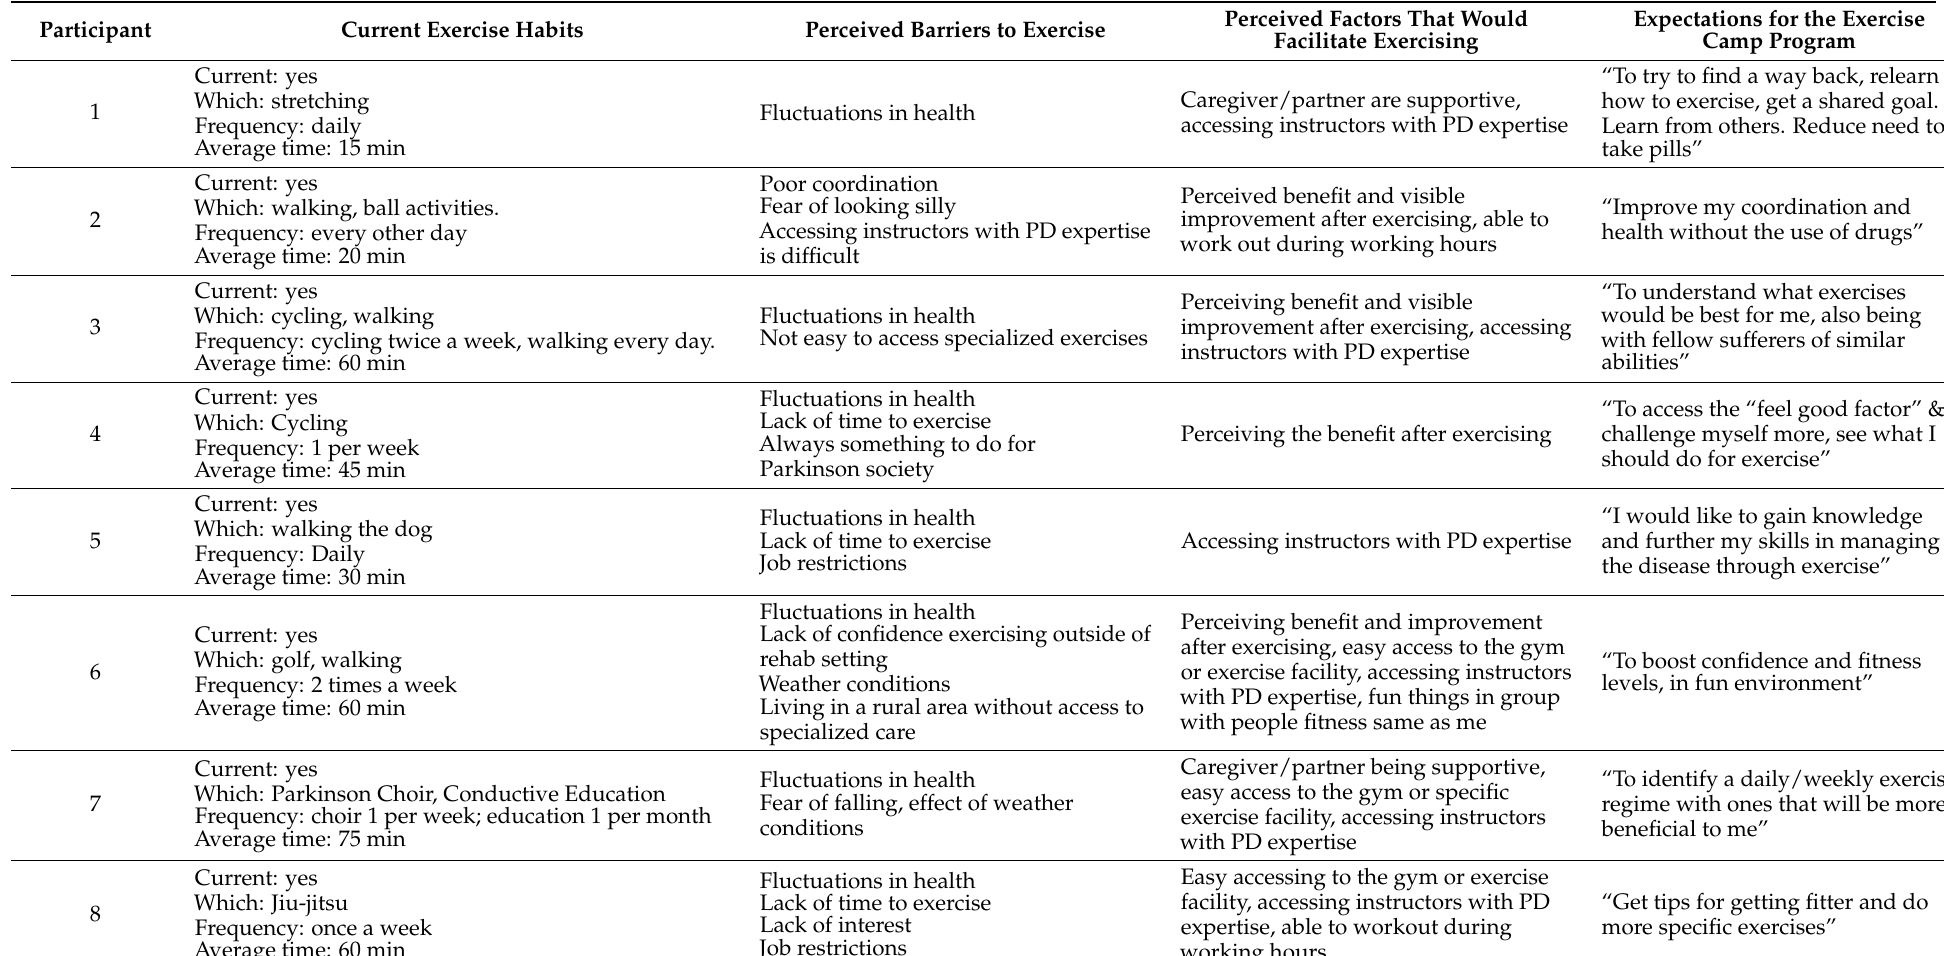
Table 3. Participants’ current exercise habits, perceived exercise barrier’s, facilitators and expectations for the boot camp.